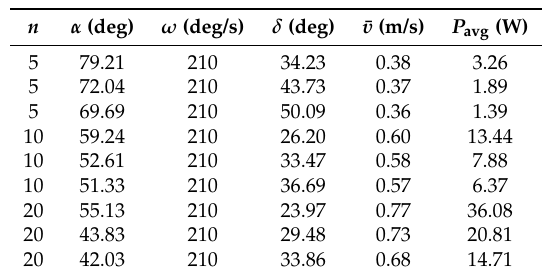
Table 4. Multi-objective optimization results for the eel-like motion pattern for the USR with different numbers of links, considering the negative work